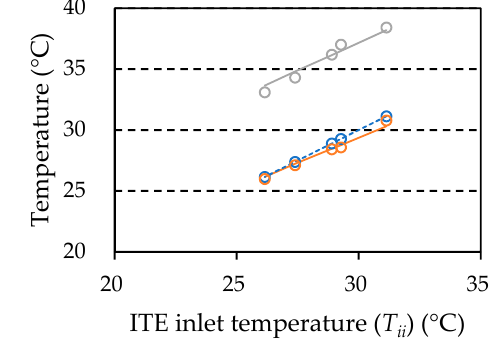
Figure 12. Experimental and prediction results for recirculation flow ( R ) with respect to availability of flow ( A f ): ( a ) C-1, ( b ) C-2, ( c ) D-1, and ( d ) D-2.